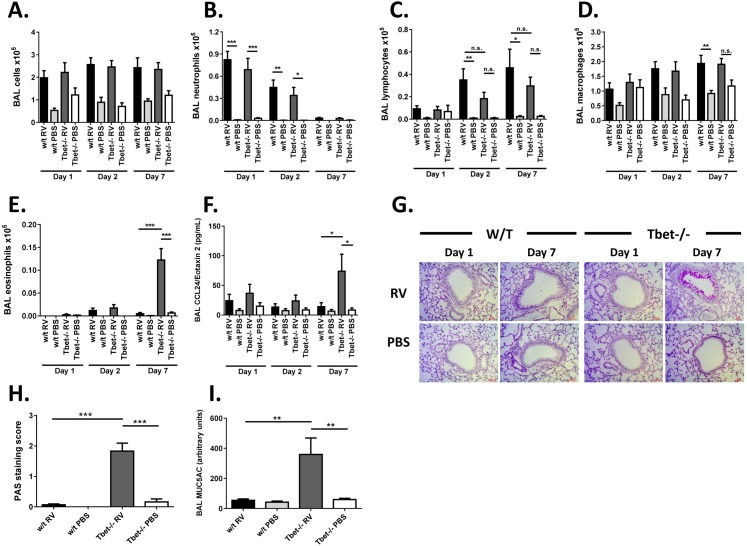
Airways inflammation in RV infected Tbet deficient and wild type mice.Wild type and Tbet-/- mice were infected intranasally with RV1B or sham infected with PBS. (A-E) Lungs were lavaged on days 1, 2 and 7 post-challenge. Total cells were counted (A), and neutrophils (B), lymphocytes (C), macrophages (D) and eosinophils (E) were enumerated by differential counting of cytospin slides. (F) CCL24/eotaxin2 levels in BAL supernatant as measured by ELISA. (G) Representative images and (H) scores for PAS mucin staining in paraffin wax embedded lungs harvested on day 7 post-infection. (I) Levels of mucin protein MUC5AC in BAL supernatants on day 7 post-challenge as measured by ELISA. Scale bars 50μm. n = 7–8 mice/group. ***p<0.001, **p<0.01, *p<0.05, n.s. not significant.